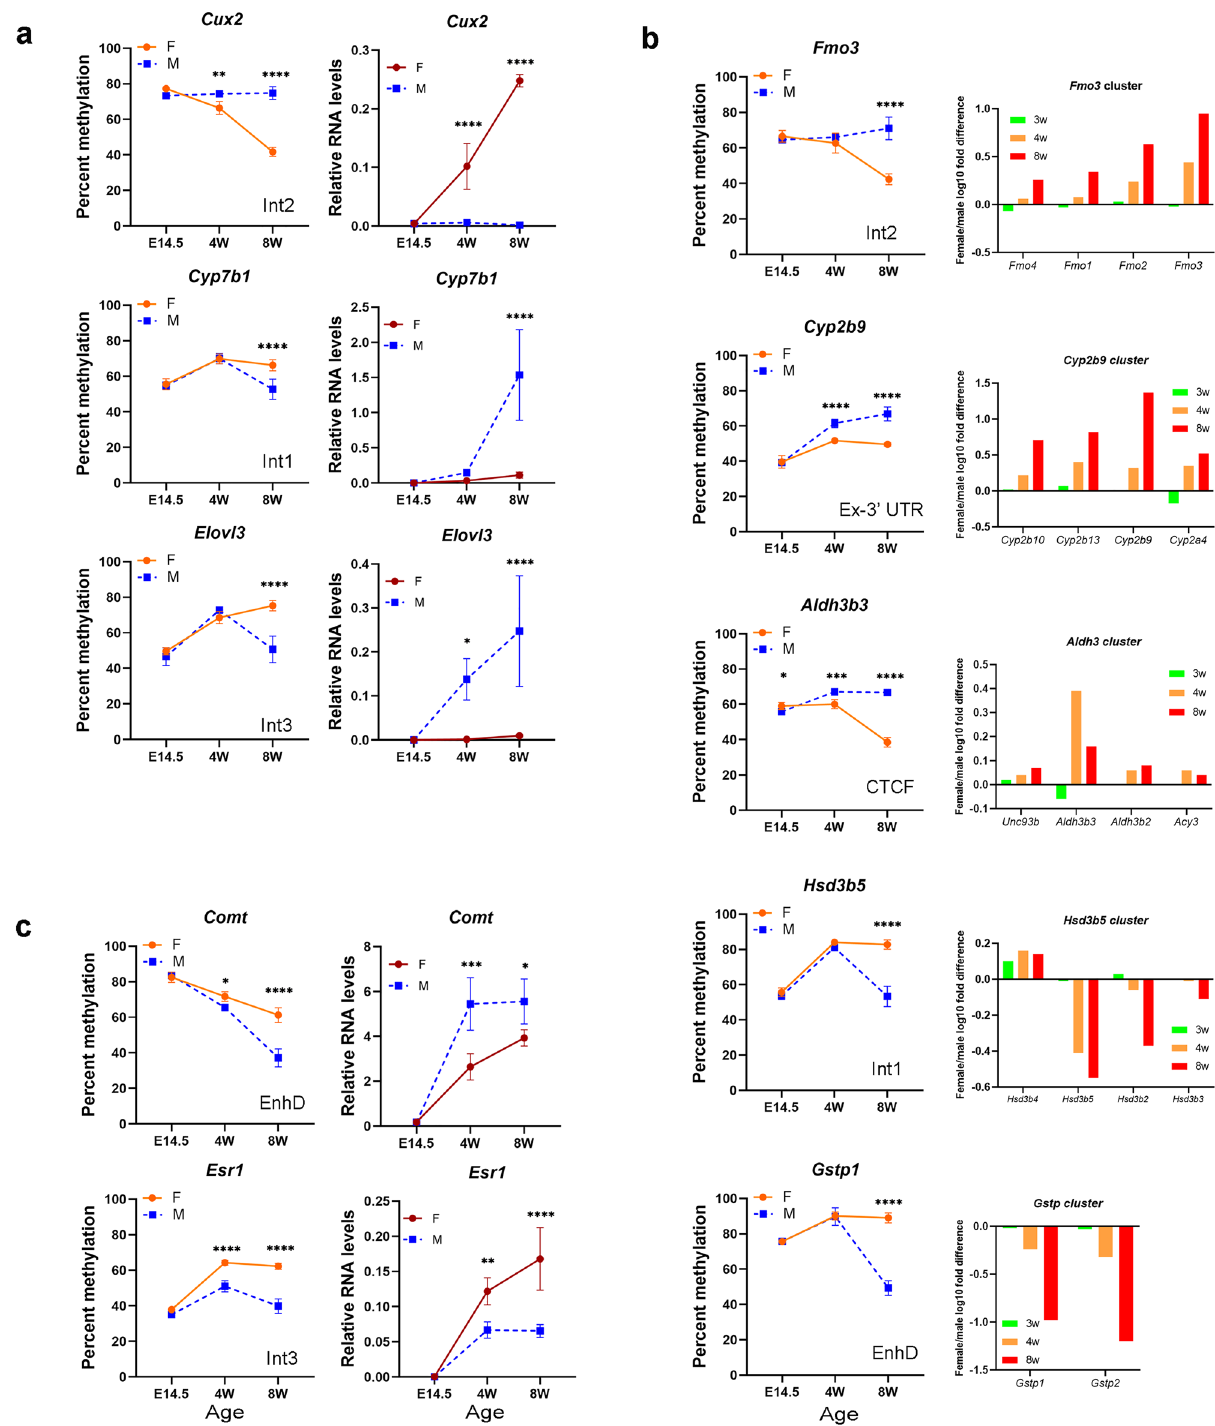
Figure 1. DNA methylation of sDMRs and proximal sDEGs expression during development. ( a ) Methylation levels of sDMRs and expression levels of proximal sDEGs for sDMRs associated with a single sDEG (4–6 females and 4–6 males at E14.5, 7 females and 4 males at 4 weeks, and 4 females and 6 males at 8 weeks of age); ( b ) Left panel, methylation levels of sDMRs with several proximal sDEGs . Right panel, log10 fold difference in gene expression between females and males from dataset GSE34782 9 . ( c ) Methylation levels of sDMRs and expression levels of proximal genes that did not reach the threshold for sDEG. Location of the sDMR with respect to genomic features is noted as: Int—intron; Ex—exon, EnhD—distal enhancer; CTCF—CTCF-bound region. Error bars show standard deviation. Statistically significant differences between sexes are shown with asterisks * P < 0.05, ** P < 0.01, *** P < 0.001; **** P < 0.0001 (two-way ANOVA followed by multiple testing with Sidak’s